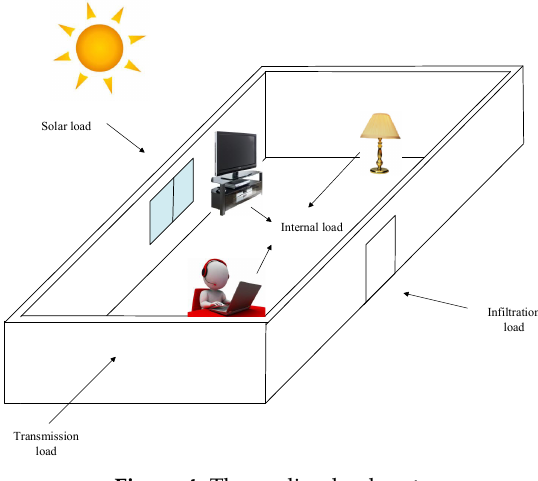
Figure 4. The cooling load